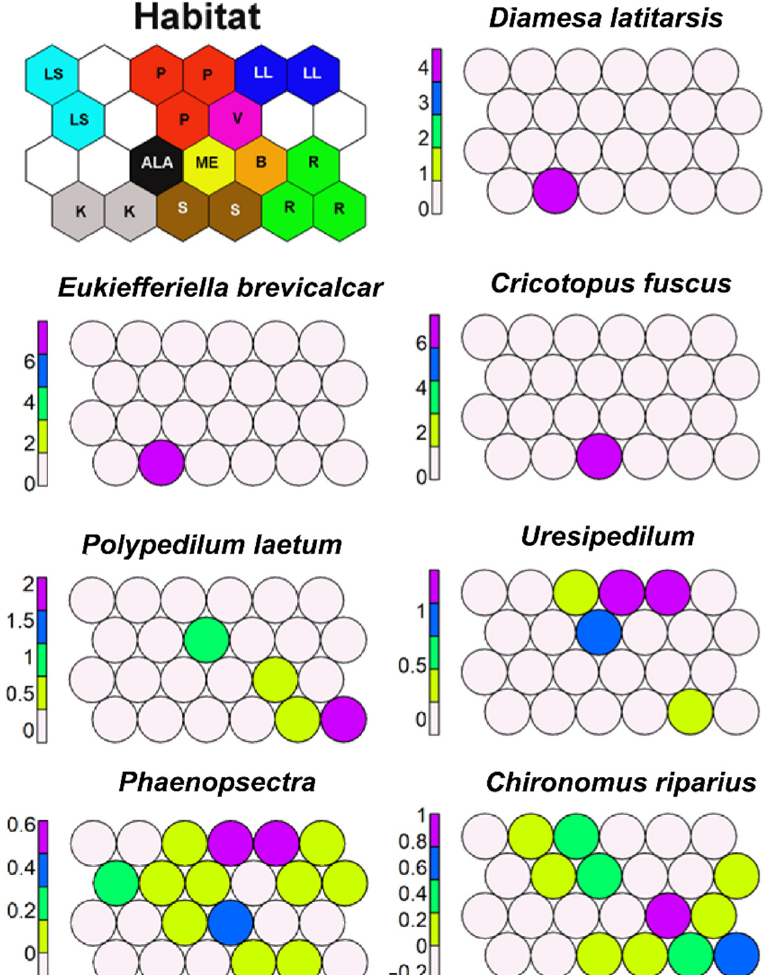
Figure 12. Supervised map of sites clustered using habitat as external factor. Habitat types considered are: kryal (K, grey), krenal (S, brown), rhithral (R, green), potamal (P, red), small (LS, azure) and large lakes (LL, blue), Alpine lakes (ALA, black), Mediterranean lakes (ME, yellow), and volcanic lakes (V, magenta), brackish waters (B, orange), and supervised map of seven morphotaxa, using habitat as external factor.